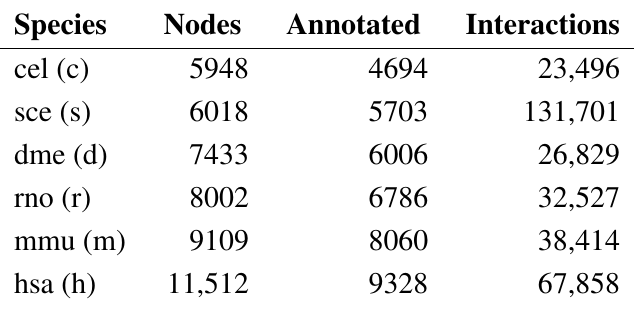
Table 1. Characteristics of input networks considered in this study. The columns contain species identifier, number of nodes in the network, number of nodes annotated with at least one gene ontology (GO) term, and number of